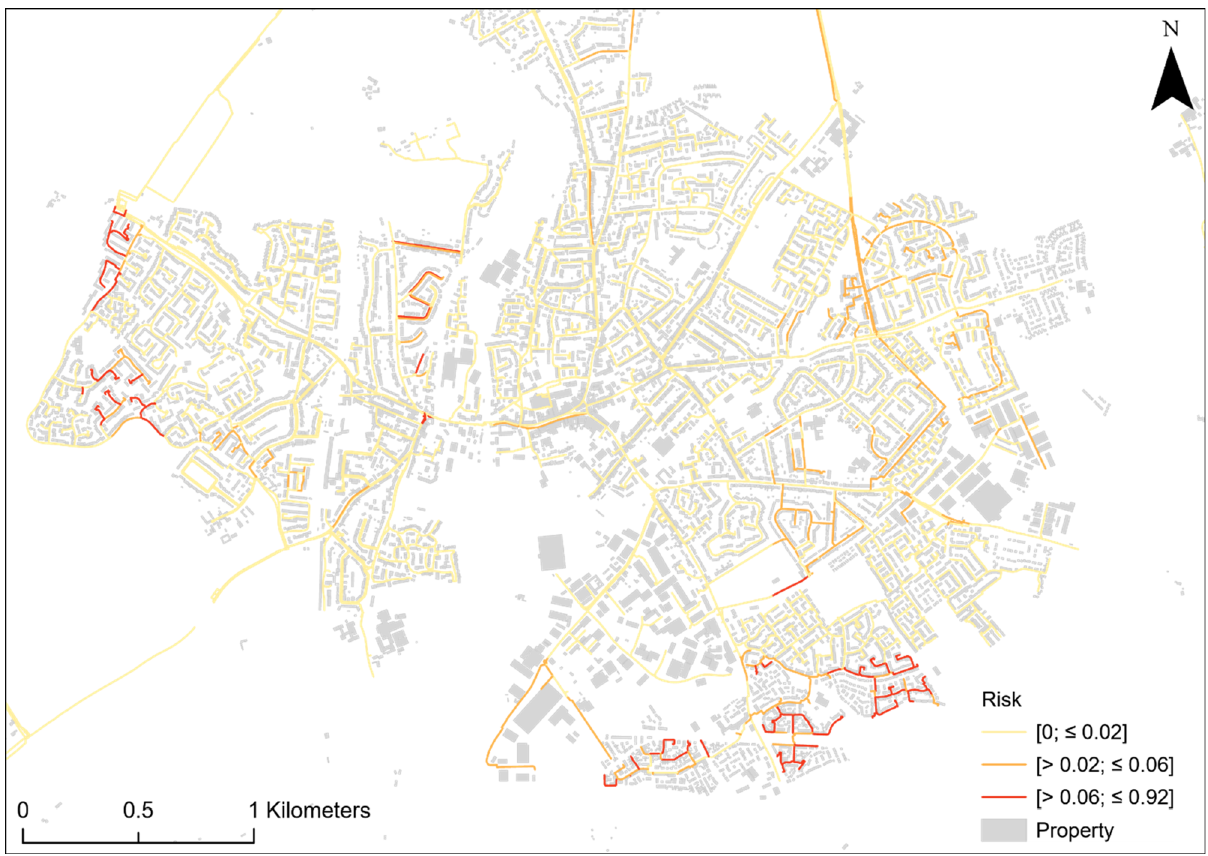
Fig. 4 Choropleth weighted risk map categorised using Natural Jenks. Risk is calculated as a measure of the probability of pipe failure and the consequence of damage to nearest property and water lost based on pipe diameter. The map represents approximately 2% of the entire UK